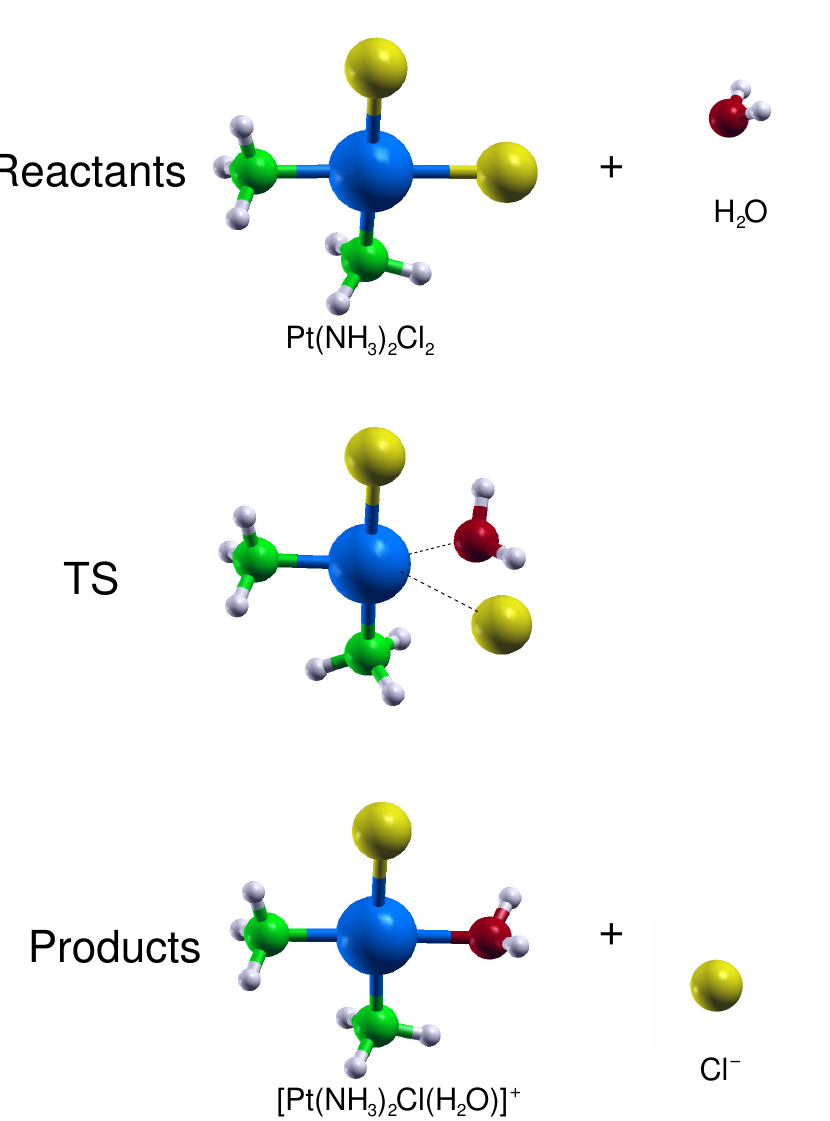
Figure 4. Side views of the reactants, transition state (TS) and products optimized structures related to the CP hydrolysis reaction. The reported structures are those obtained in aqueous solution by considering the SMD continuum solvation